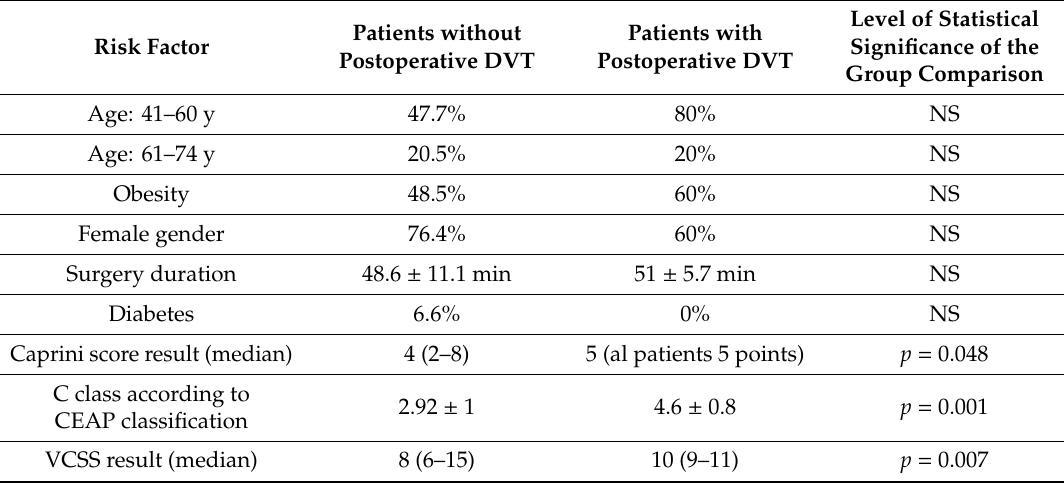
Table 2. Group comparison in regard to the potential identified VTE risk factor presence: 136 patients without postoperative deep vein thrombosis (DVT) vs. DVT positive group.